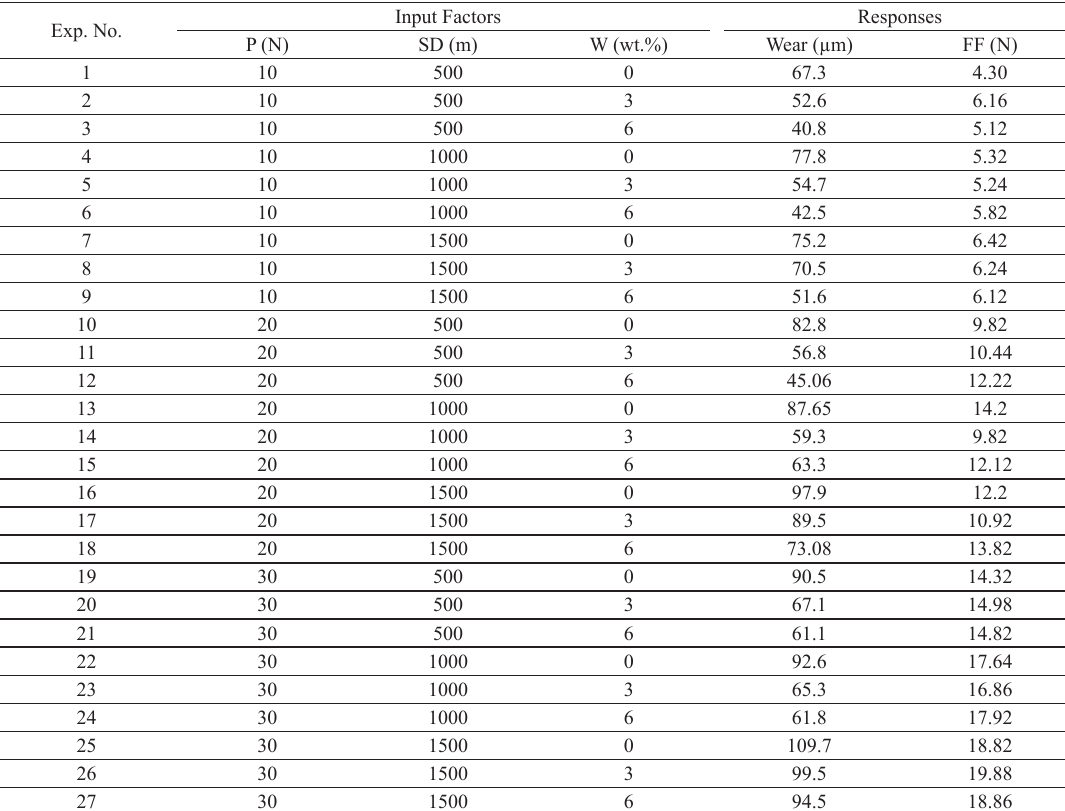
Table 2. Experimental layout. Exp.